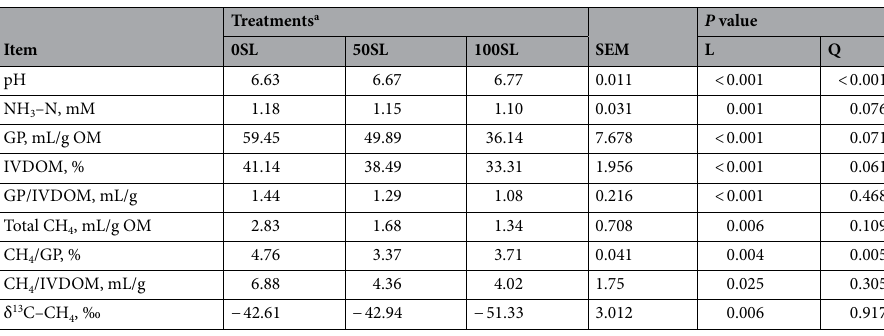
Table 1. Forty-eight-hour in vitro fermentation parameters of three proportions of sericea lespedeza [SL; Lespedeza cuneata (Dum. Cours.) G. Don] hay with bermudagrass[ Cynodon dactylon (L.) Pers.] hay diets from Trial 1. GP, gas production; IVDOM, in vitro digestible organic matter; NH 3 –N, ammonia–nitrogen; CH 4 , methane; SEM, standard error of the mean; L, linear effect of SL inclusion; Q, quadratic effect of SL inclusion. a 0SL: 0% (fresh weight basis) sericea lespedeza hay (100% bermudagrass hay); 50SL: 50% sericea lespedeza hay + 50% bermudagrass hay; 100SL: 100% sericea lespedeza hay (0% bermudagrass hay).